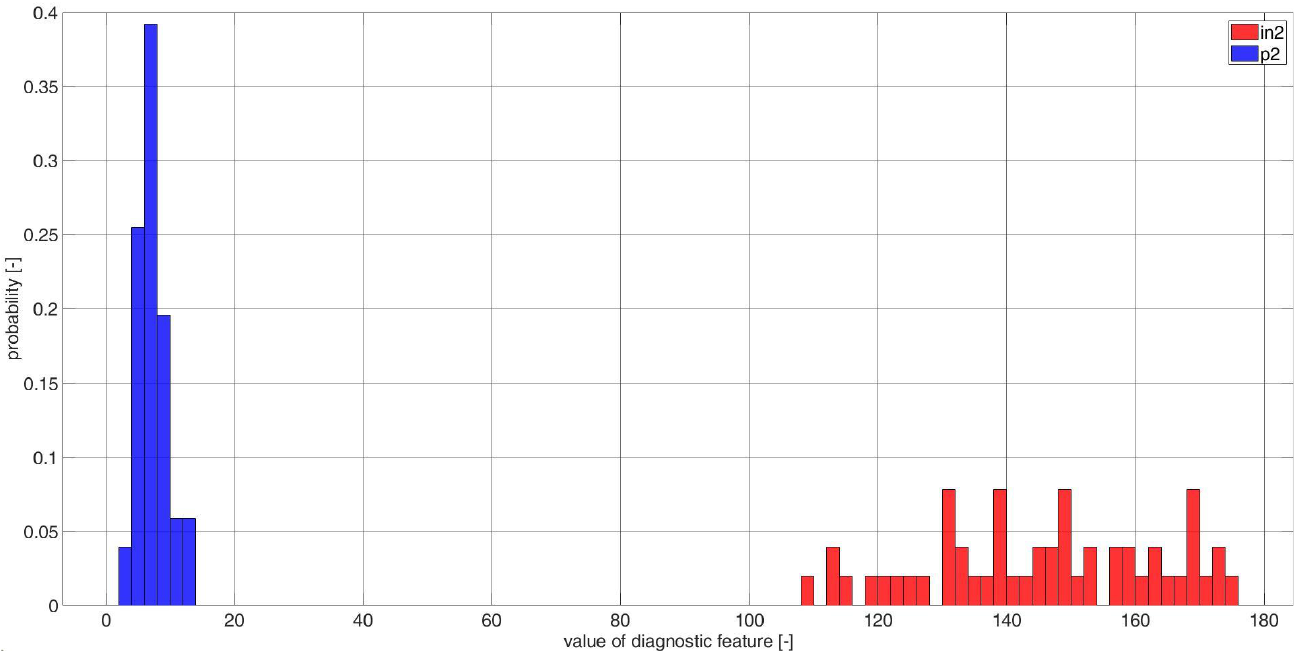
Figure A21. Histograms of diagnostic features based on the CCSM3 (correlation number is 22— Table A1) bearings in1 and p1. Table A1) bearings in1 and p1.